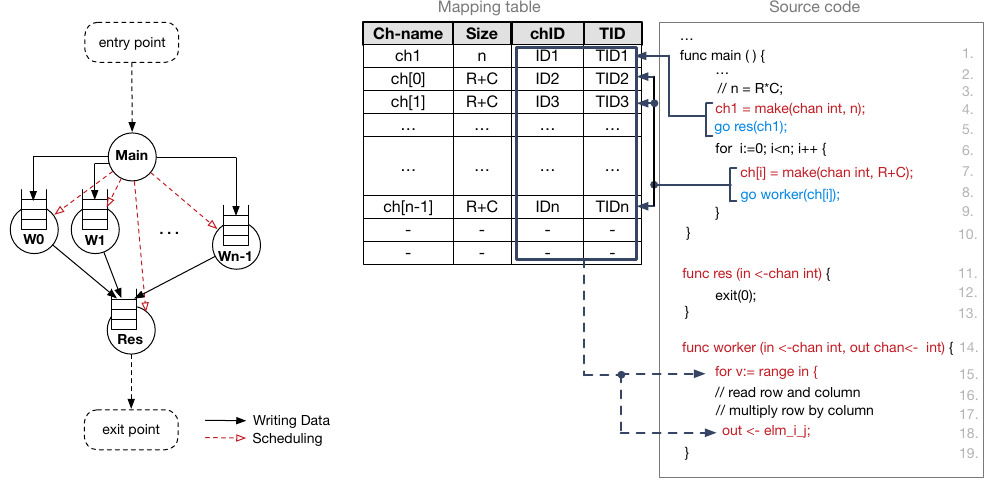
Figure 8. General matrix-matrix multiplication (GEMM) kernel written in Go ( right ). On the left side, the corresponding dataflow graph along with the mapping